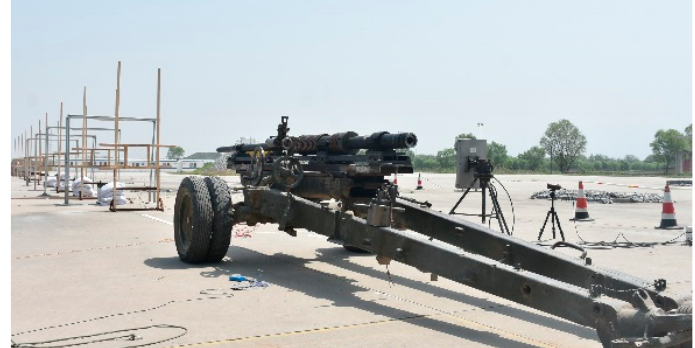
Figure 1. Schematic diagram of experimental system.